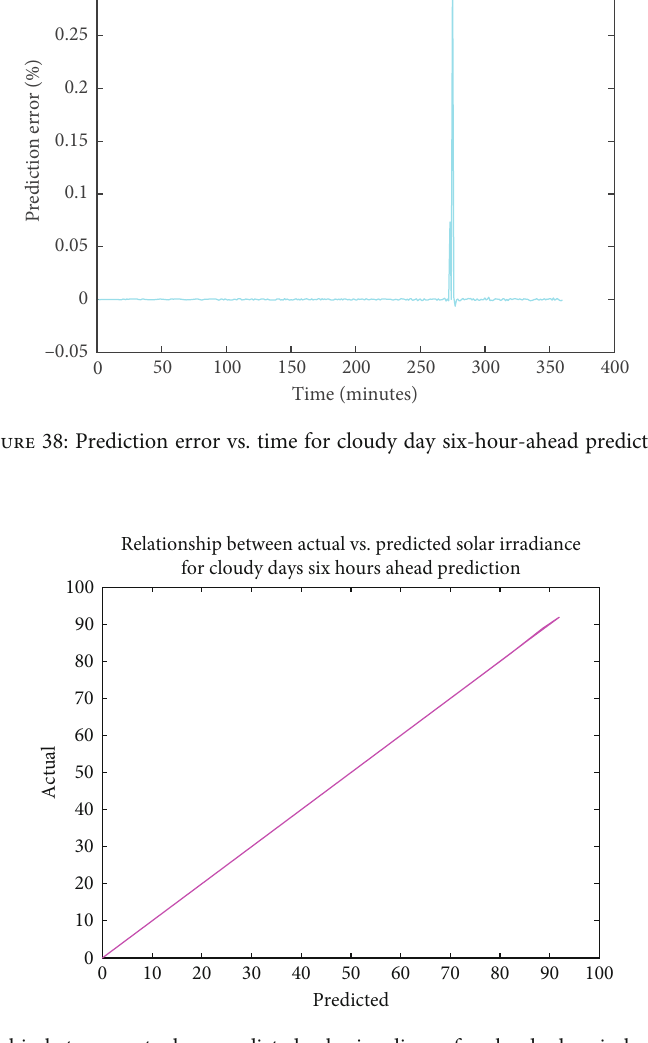
Figure 39: Relationship between actual vs. predicted solar irradiance for cloudy day six-hour-ahead